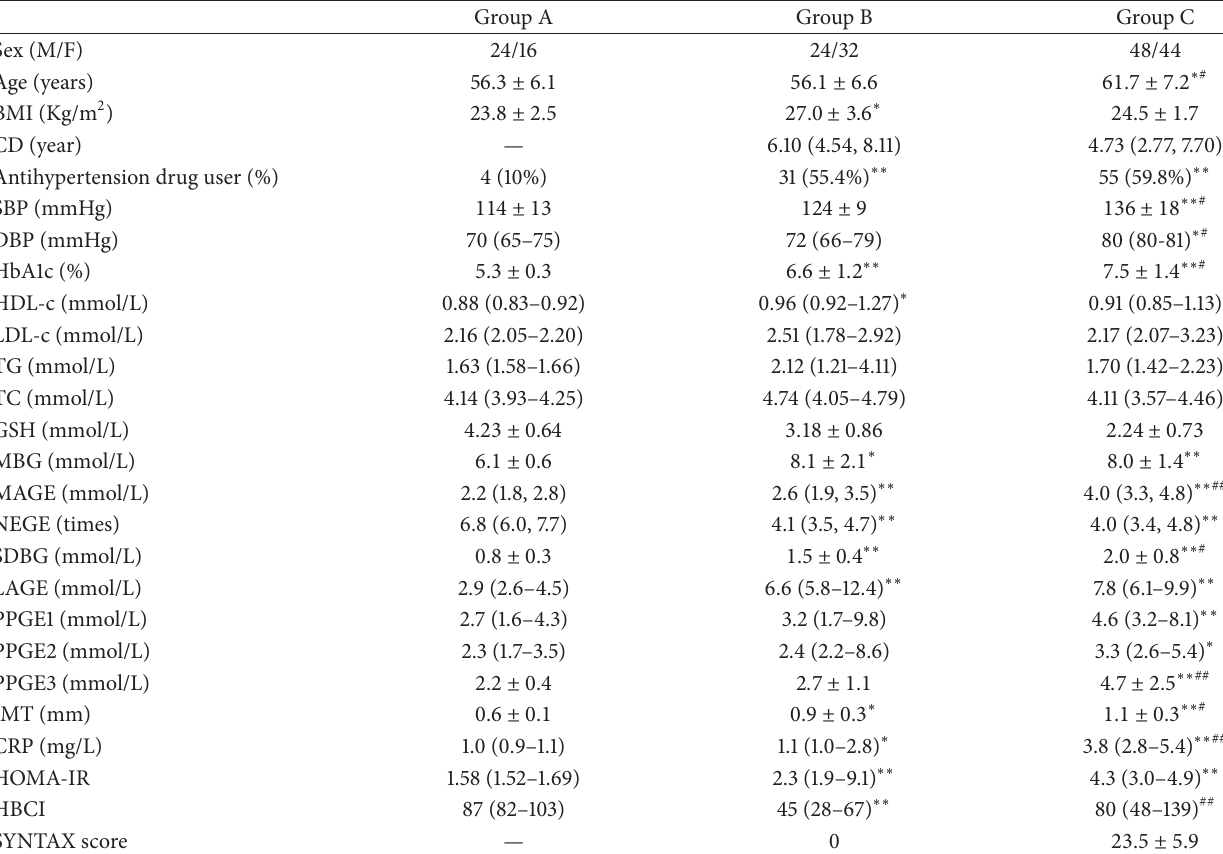
Table 1: Comparison of the indexes in the three